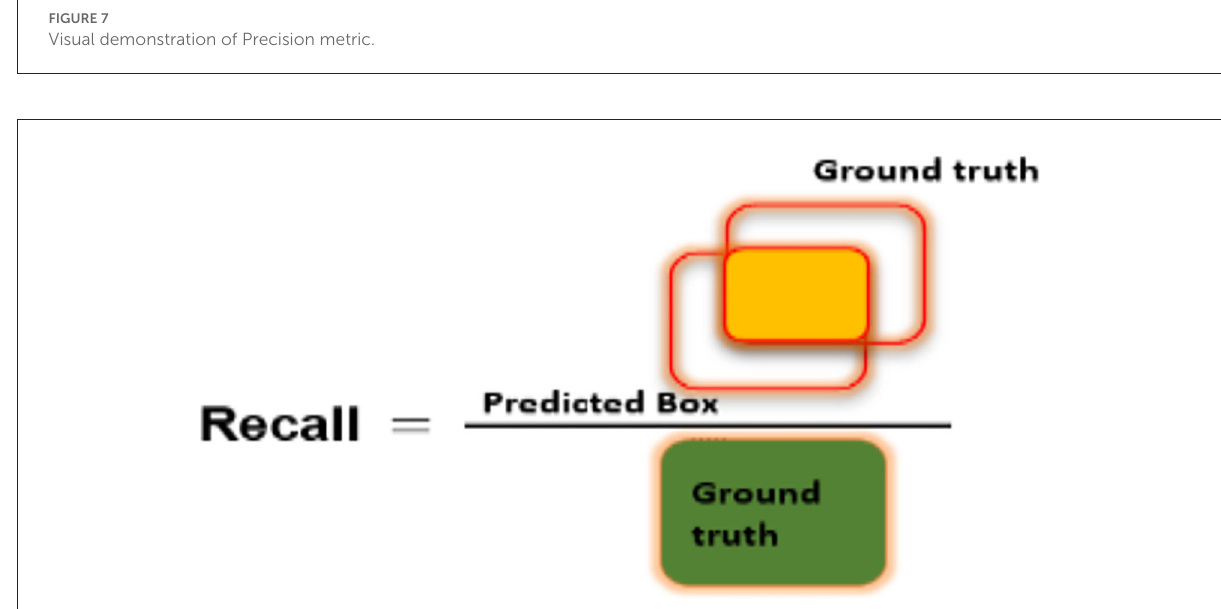
FIGURE8 Pictorial representation of Recall